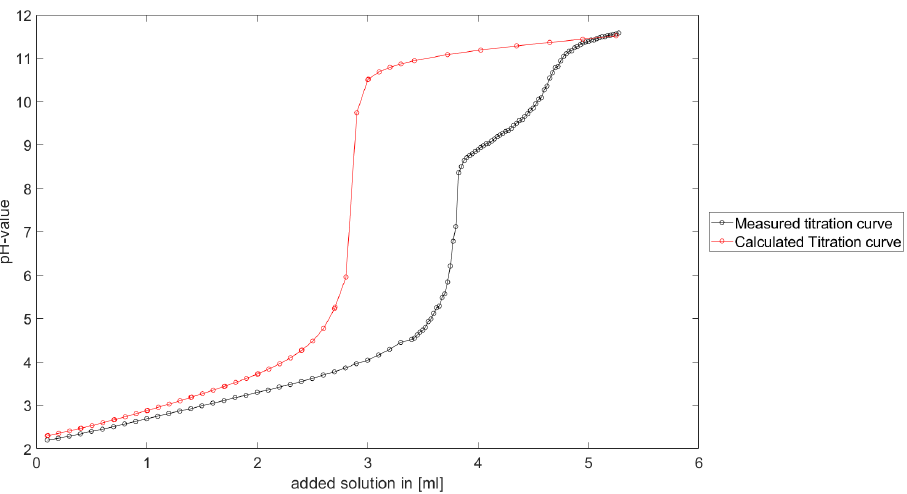
Figure 11. Comparison of a calculated titration curve of the Cit-Ni electrolyte, with literature parameters given in Table 7, and measured Cit-Ni titration curve.